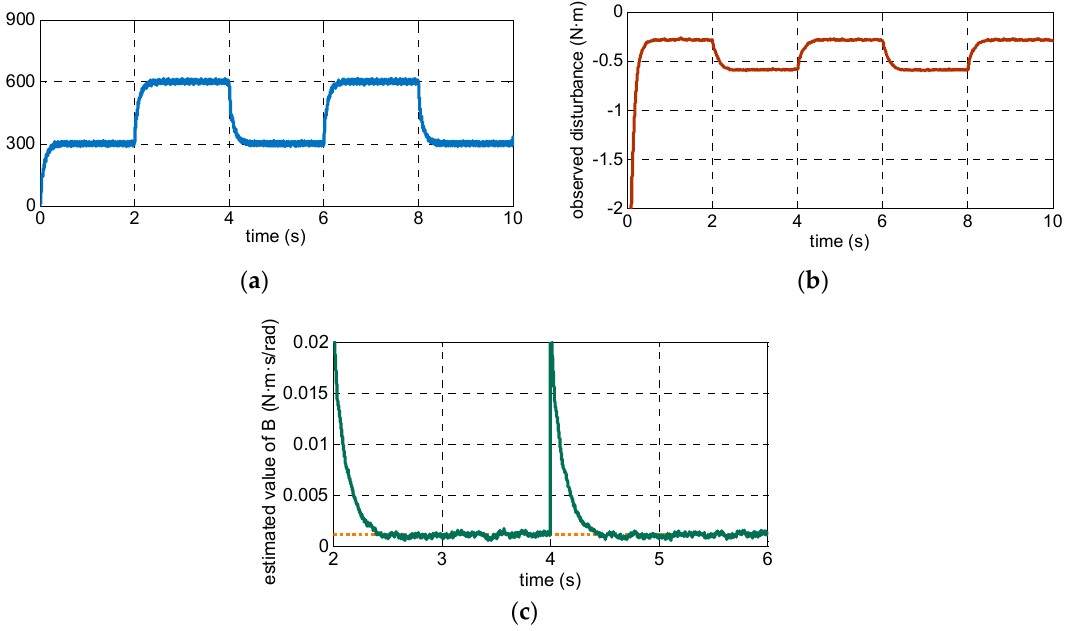
Figure 12. Experimental results under alternate speeds of 300 and 600 rpm for B 0 = 10 B : ( a ) Measured speed; ( b ) observed disturbance value for parameter mismatch error Δ B ; ( c ) estimated value of parameter B .